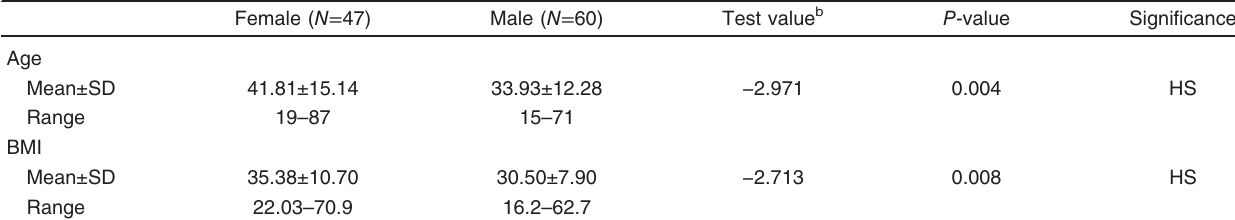
Table 2 Comparison between men and women as regards age and BMI